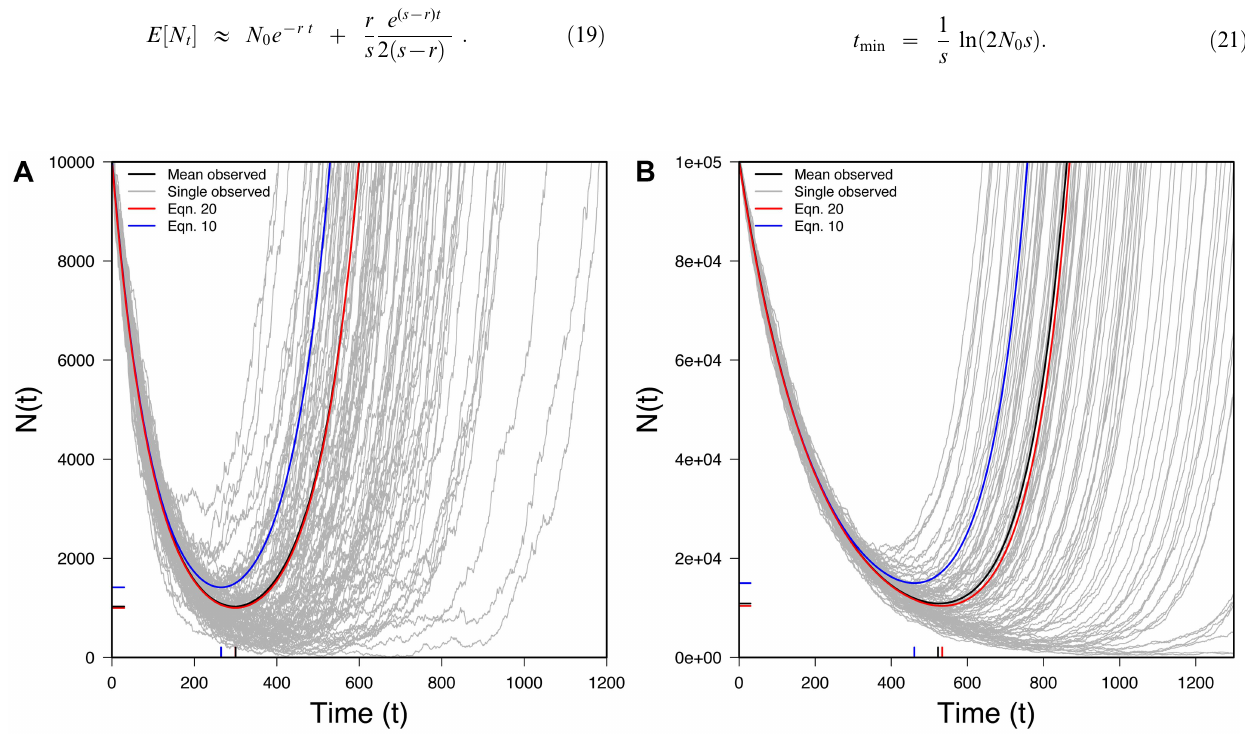
Figure 6. The U-shaped curve for populations rescued by new mutation. 100 randomly selected successful realizations in gray, mean of all successful realizations in black, Eq. 19 (expectation from new mutation) in red, Eq. 10 (expectation from standing variation) in blue. Ticks on X-axis represent observed (black) and predicted (red) t min (Eq. 21) while ticks on the Y-axis represents observed (black) and predicted (red) N min (Eq. 22). A) N 0 =10,000, r =0.01, s =0.02, u =10 2 5 B) N 0 =100,000, r =0.005, s =0.015, u =10 2 6 ; 10,000 realizations.